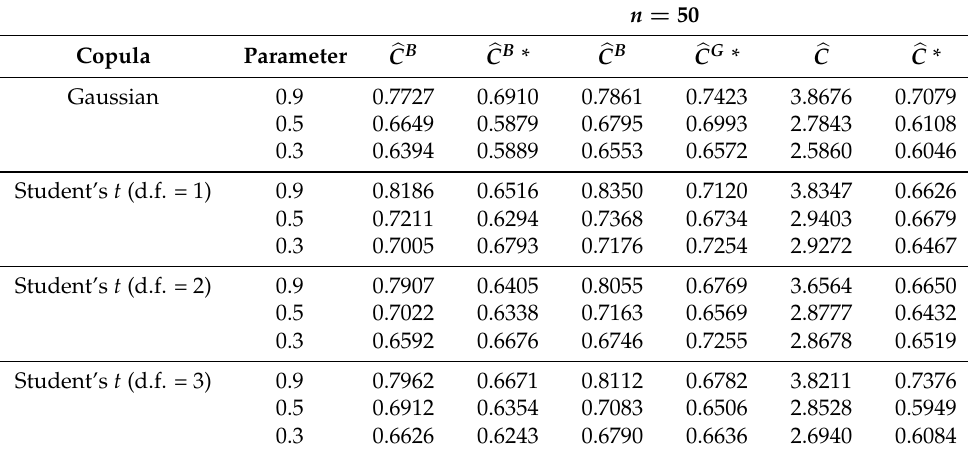
Table 1. Quotient betweenthe approximate MISE of kernel estimators of the copula (numerator) and approximate MISE of the empirical copula (denominator) for elliptical copulas (* indicates optimal